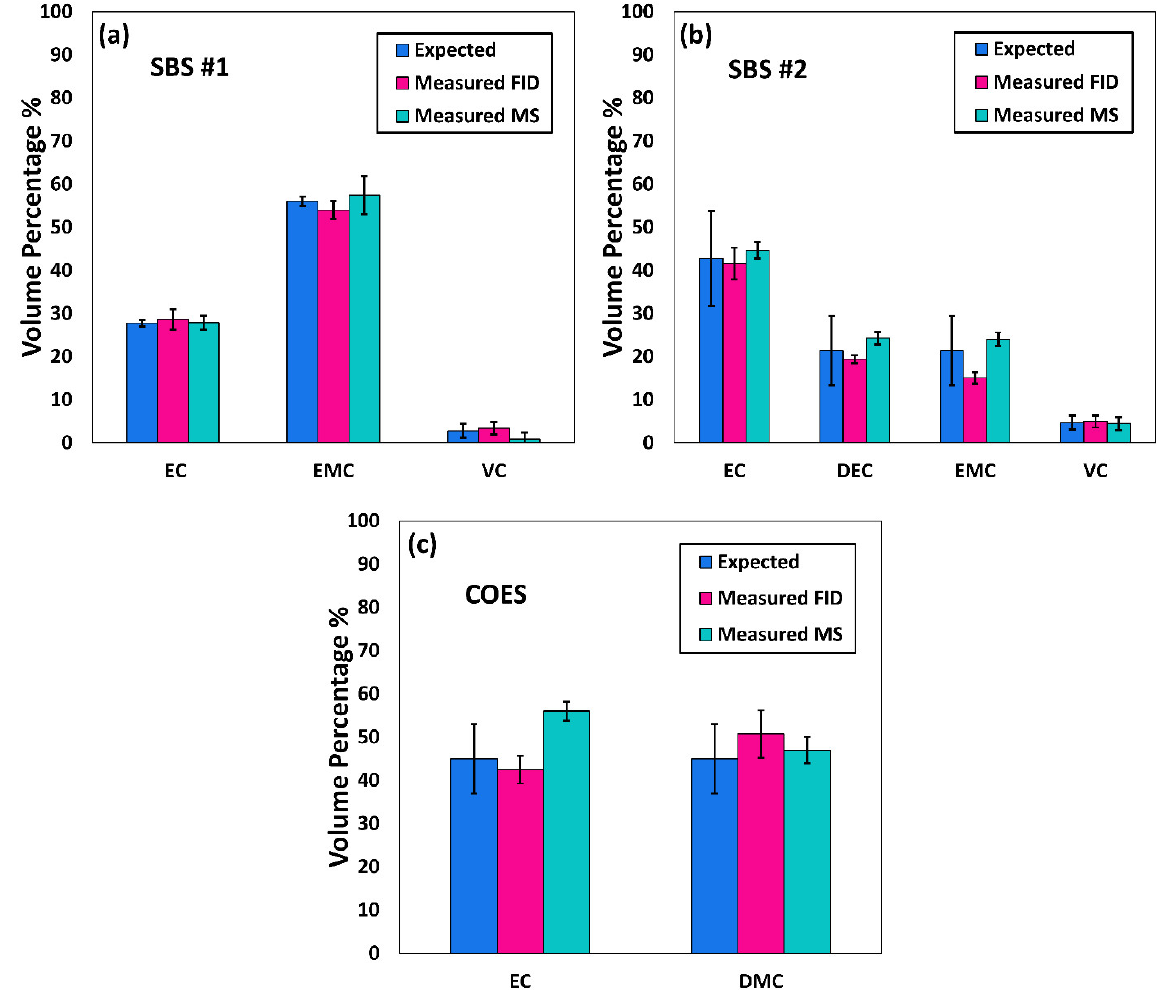
Figure 6. Volume percentages determined for carbonates in SBS #1 ( a ), SBS #2 ( b ), and COES ( c ).